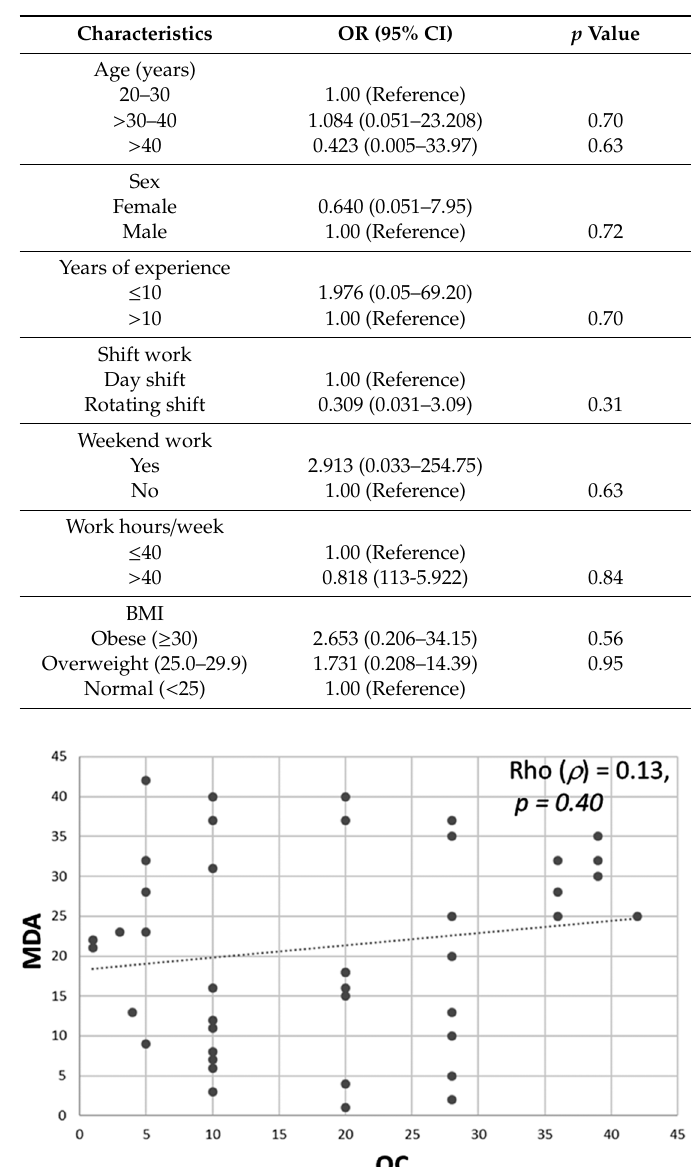
Figure 4. Scatter plot showing correlation between overcommitment (OC) and oxidative stress biomarker, malondialdehyde (MDA). OC was determined from the effort–reward imbalance (ERI) questionnaires filled out by study participants ( n = 42). Spearman rank correlation showing positive correlation between OC vs. MDA (Rho = 0.13, p = 0.40).